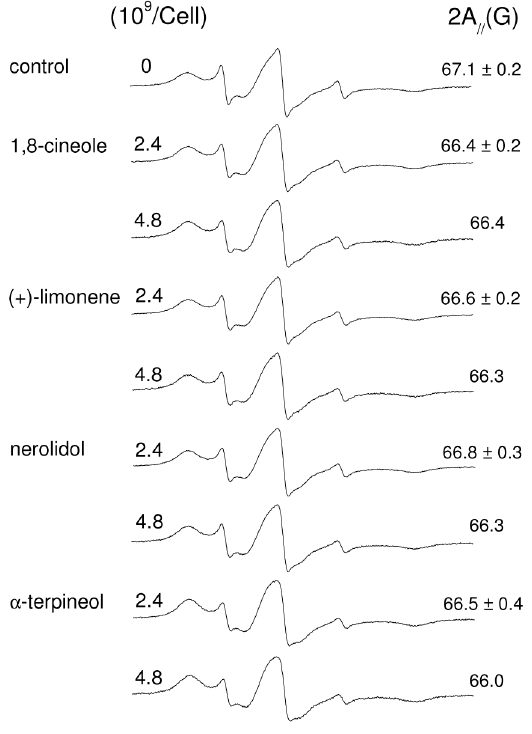
Figure 6. EPR spectra of spin-labeled membrane proteins of Leishmania for untreated and terpene-treated samples. The 2A // - parameter values are indicated.